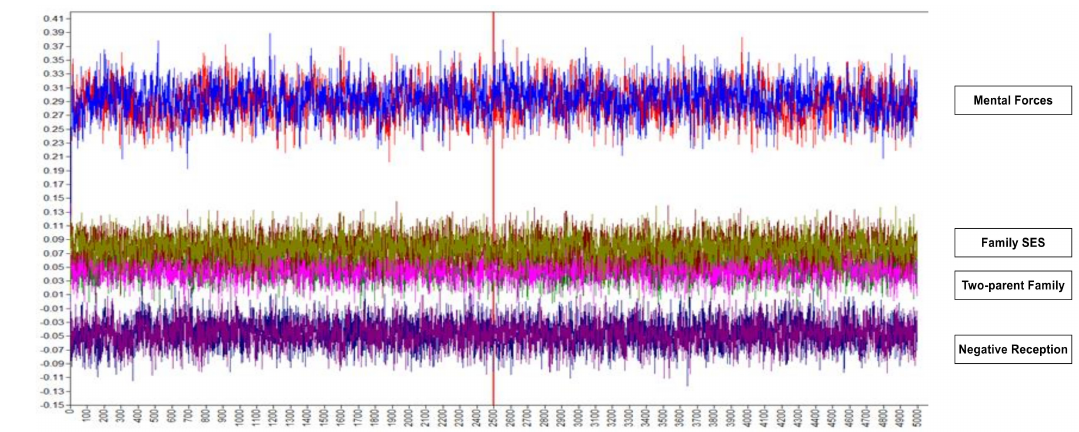
Figure A3. Bayesian posterior parameters trace plot presenting the effects of mental forces, two-parent families, family SES, and negative reception in parallel on immigrant children’s first occupational achievement. Note: The number of iterations for each Markov Chain Monte Carlo chain was modeled by setting Fbiterations = 5000 for repeated random sampling, and all individual- and school-level covariates of multilevel modeling were adjusted, PSR = 1.029.